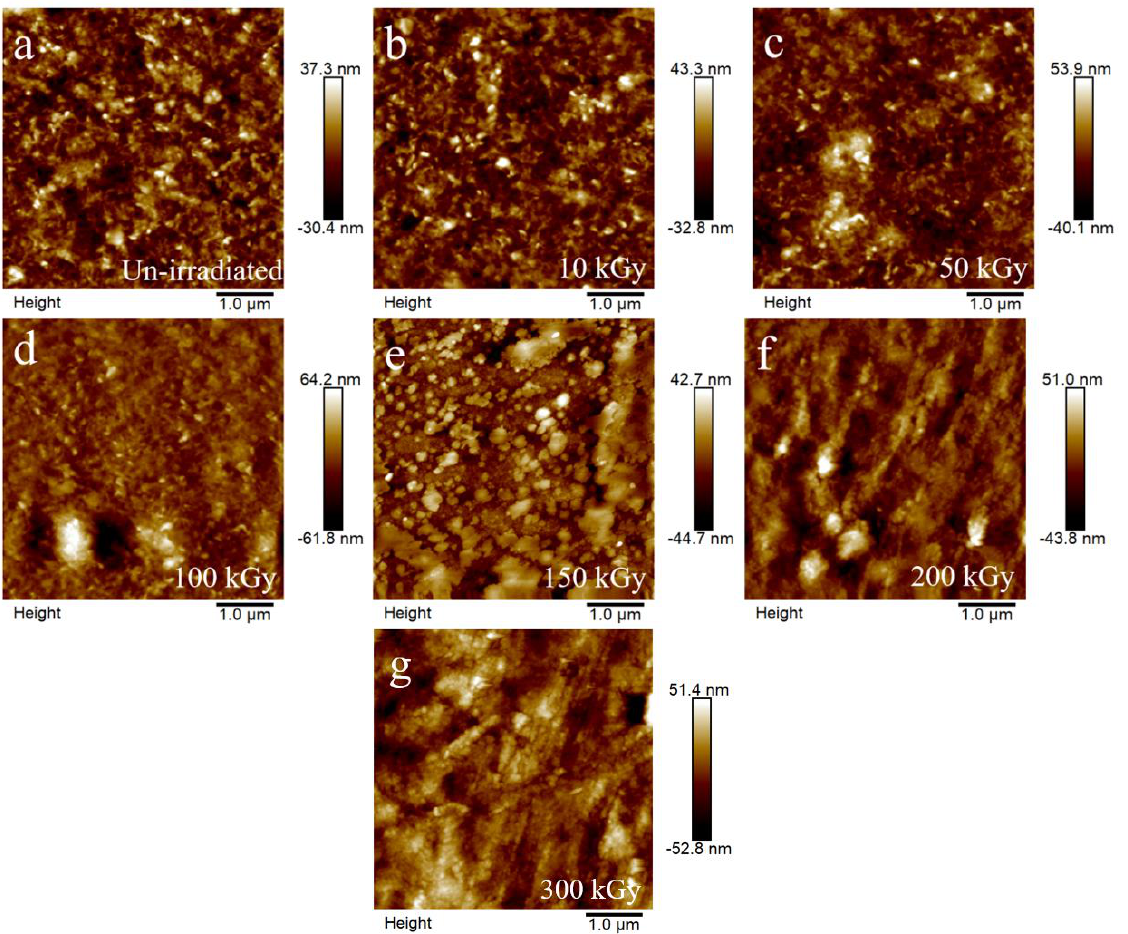
Figure 6. AFM images of MgZnO with increasing TID; ( a ) Unirradiated, ( b ) 10 kGy, ( c ) 50 kGy, ( d ) 100 kGy, ( e ) 150 kGy, ( f ) 200 kGy, ( g ) 300 kGy.